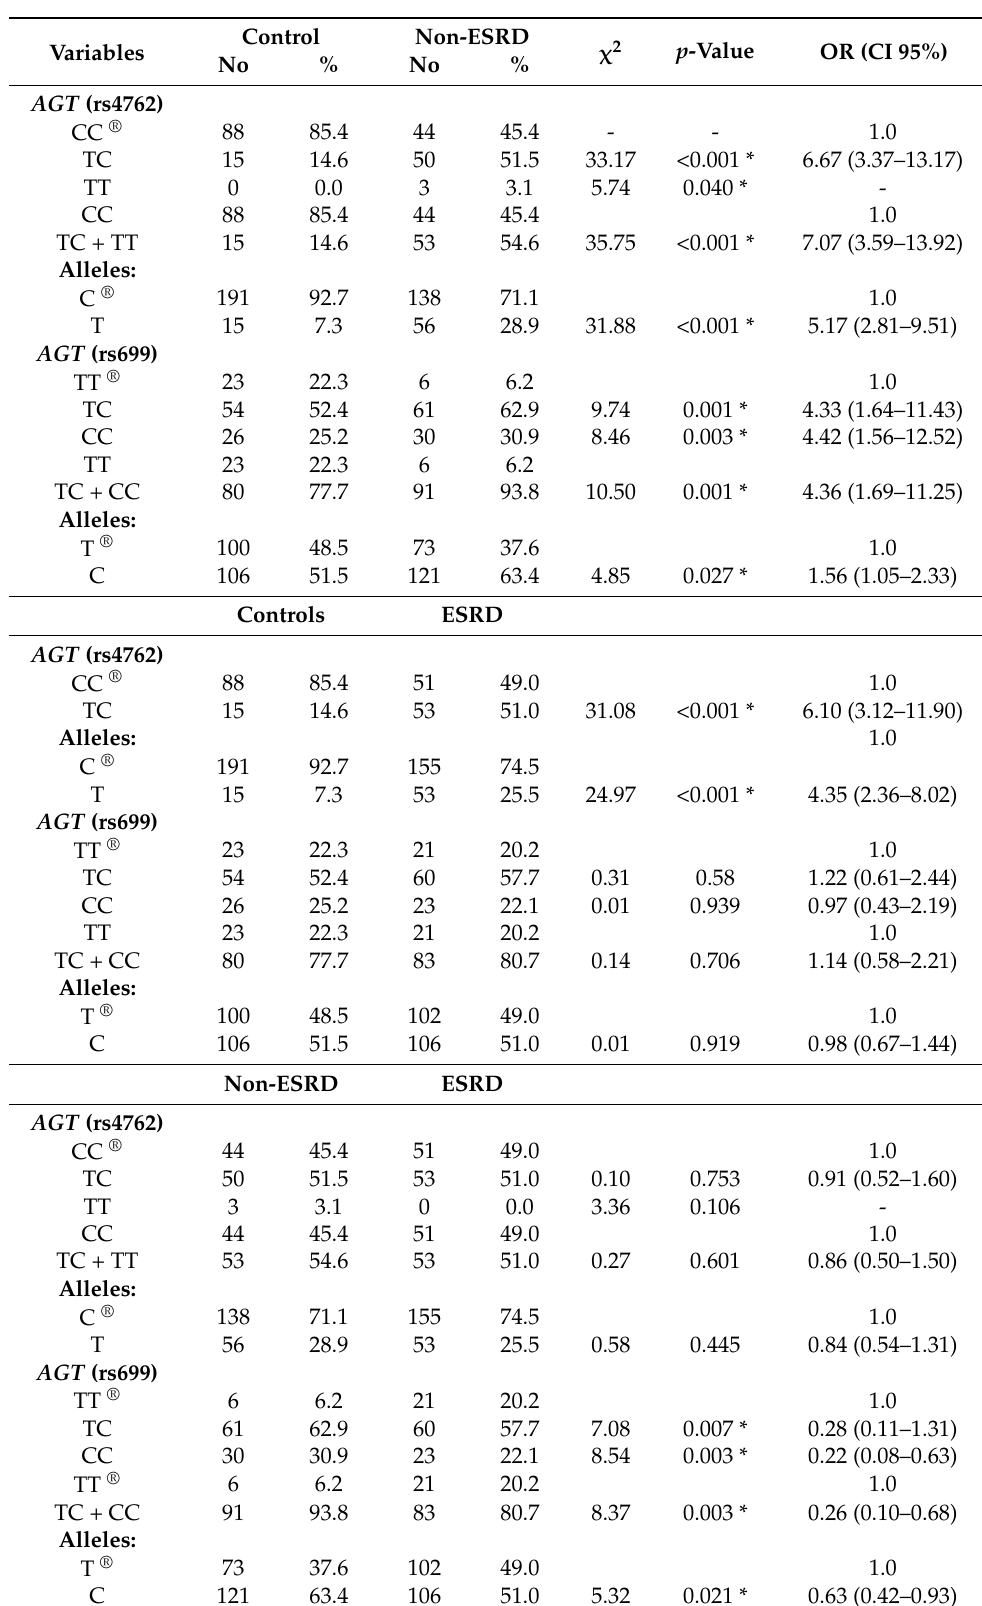
Table 4. AGT gene (rs4762 and rs699) polymorphisms under the co-dominant and allelic models in patient groups and